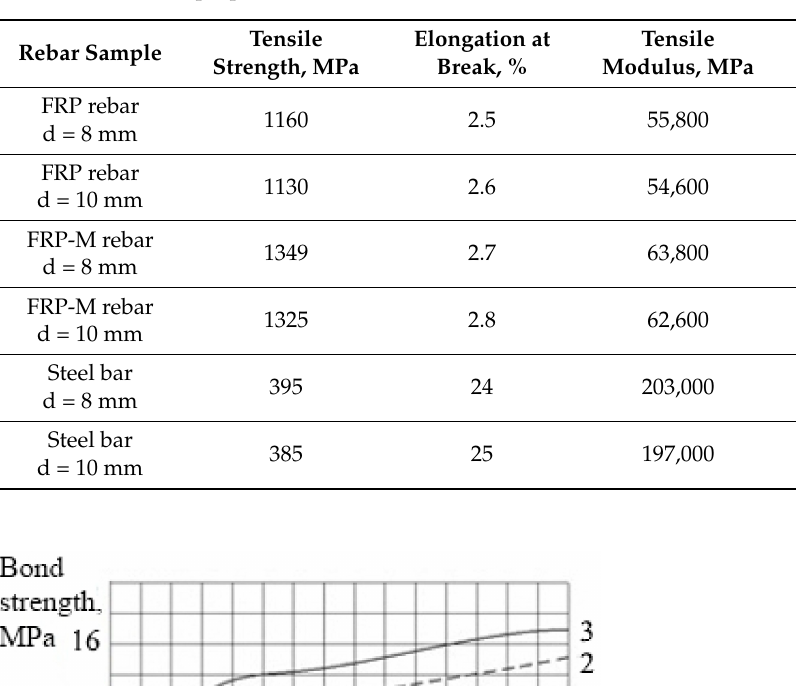
Table 2. Mechanical properties of the FRP rebars.